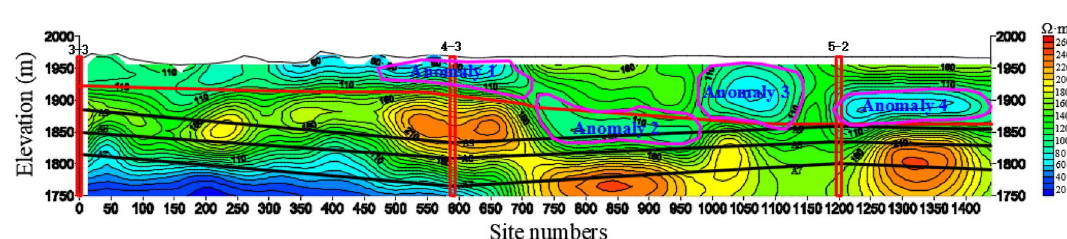
Figure 13. The resistivity profile of the TEM of L66.